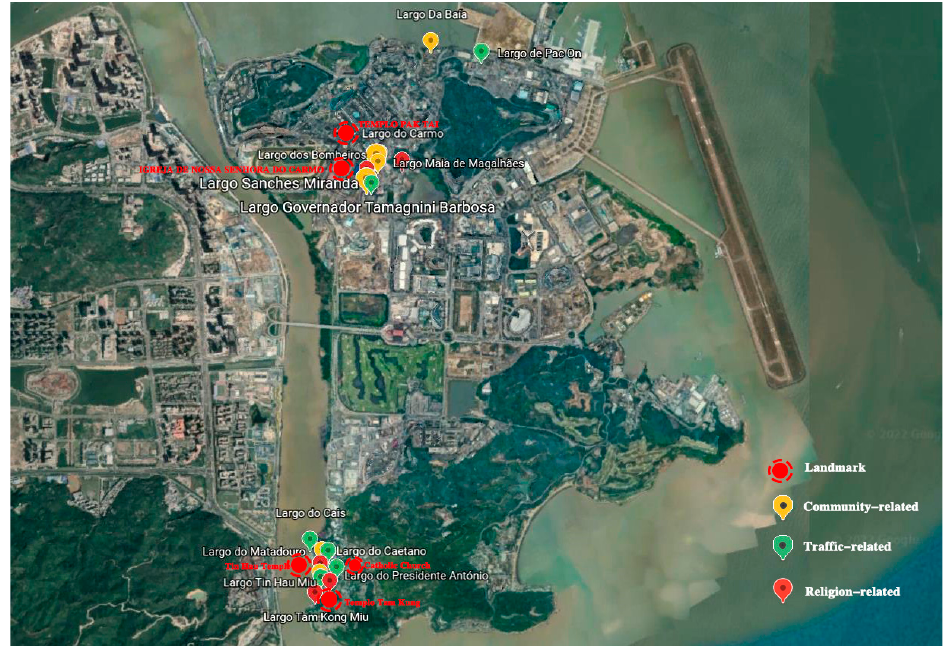
Figure 3. Location of the Largos(Peninsula Macau, redrawn based on Google Map).